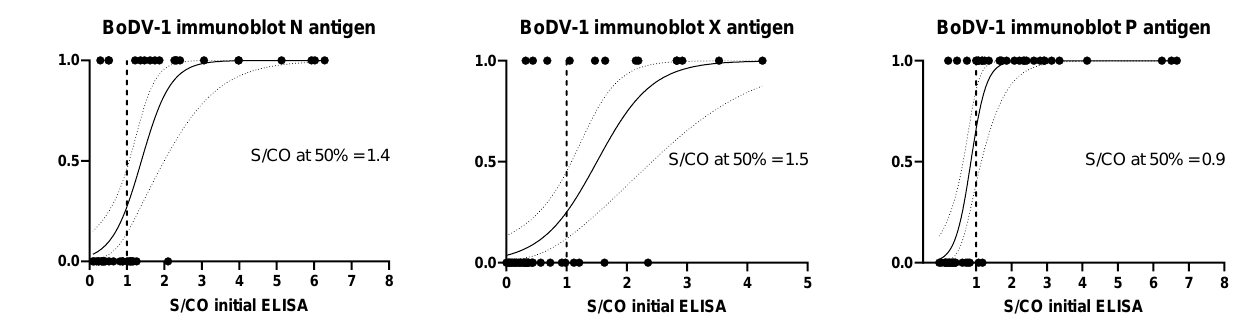
Figure 2. BoDV-1 immunoblots of selected samples with reactive ELISA results. Immunoblots were performed using the same recombinant viral proteins as used for ELISA. Under ( A ), confirmations of antigen-directed IgG antibodies by immunoblots are shown for Np40 protein (His-tagged) on the left, for Xp10 protein (tagged with a 26kDa GST-tag) in the middle, and for Pp23 (His-tagged) on the right. The values given below represent ELISA screening results of the corresponding sample. The probability of an immunoblot band increased with higher S/CO values of the screening ELISA for all used antigens ( B ). Shown are the best-fit lines for logistic regression (0 = no immunoblot band, 1 = immunoblot band) with 95% confidence intervals. Vertical dotted lines represent the ELISA cut- off.